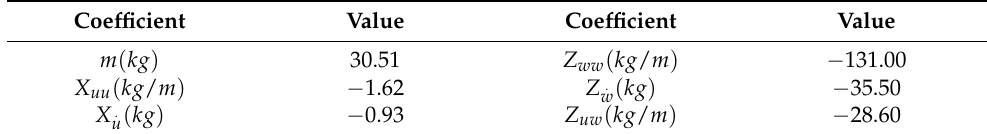
Table 1. The nonlinear hydrodynamic coefficients of REMUS model AUV.